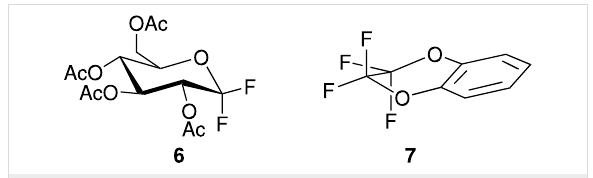
Figure 3: Structures of 6 and 7